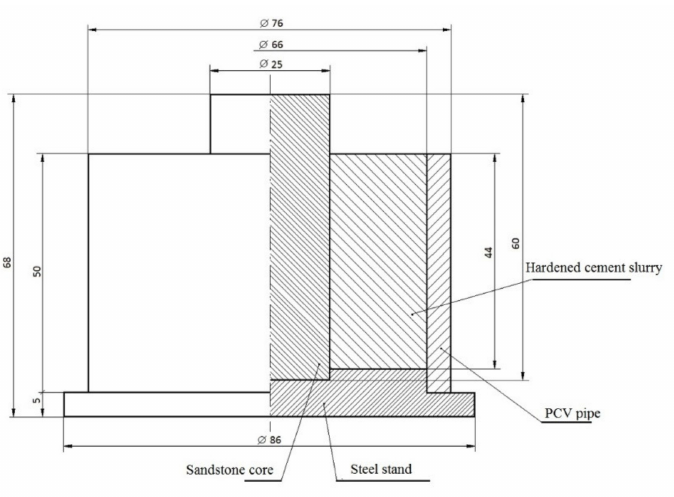
Figure 11. Half-section of the mold with the sample core